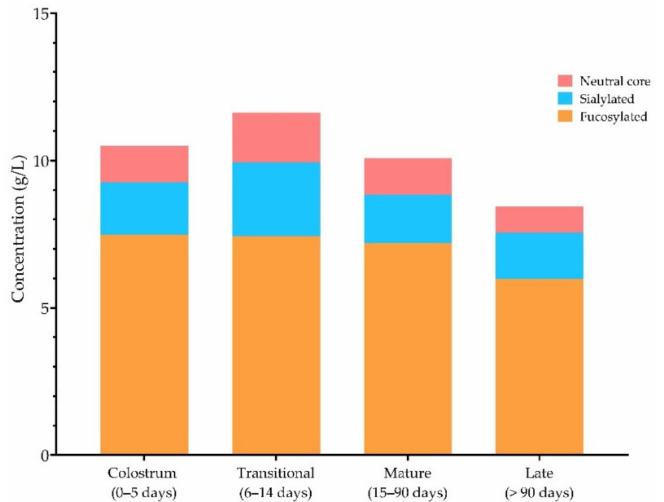
Figure 3. Portions of the neutral core, fucosylated and sialylated HMO groups throughout the pre-defined lactation periods. The Figure was obtained by summing the individual structures in the categories of fucosylated, sialylated, and neutral-core. All the structures are provided in Supplementary Materials Table